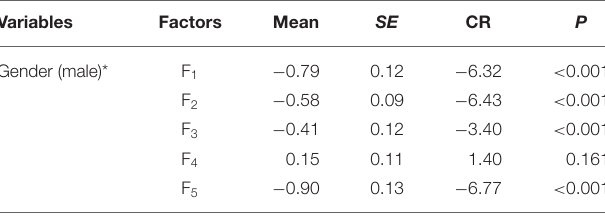
TABLE 5 | Group mean differences in latent